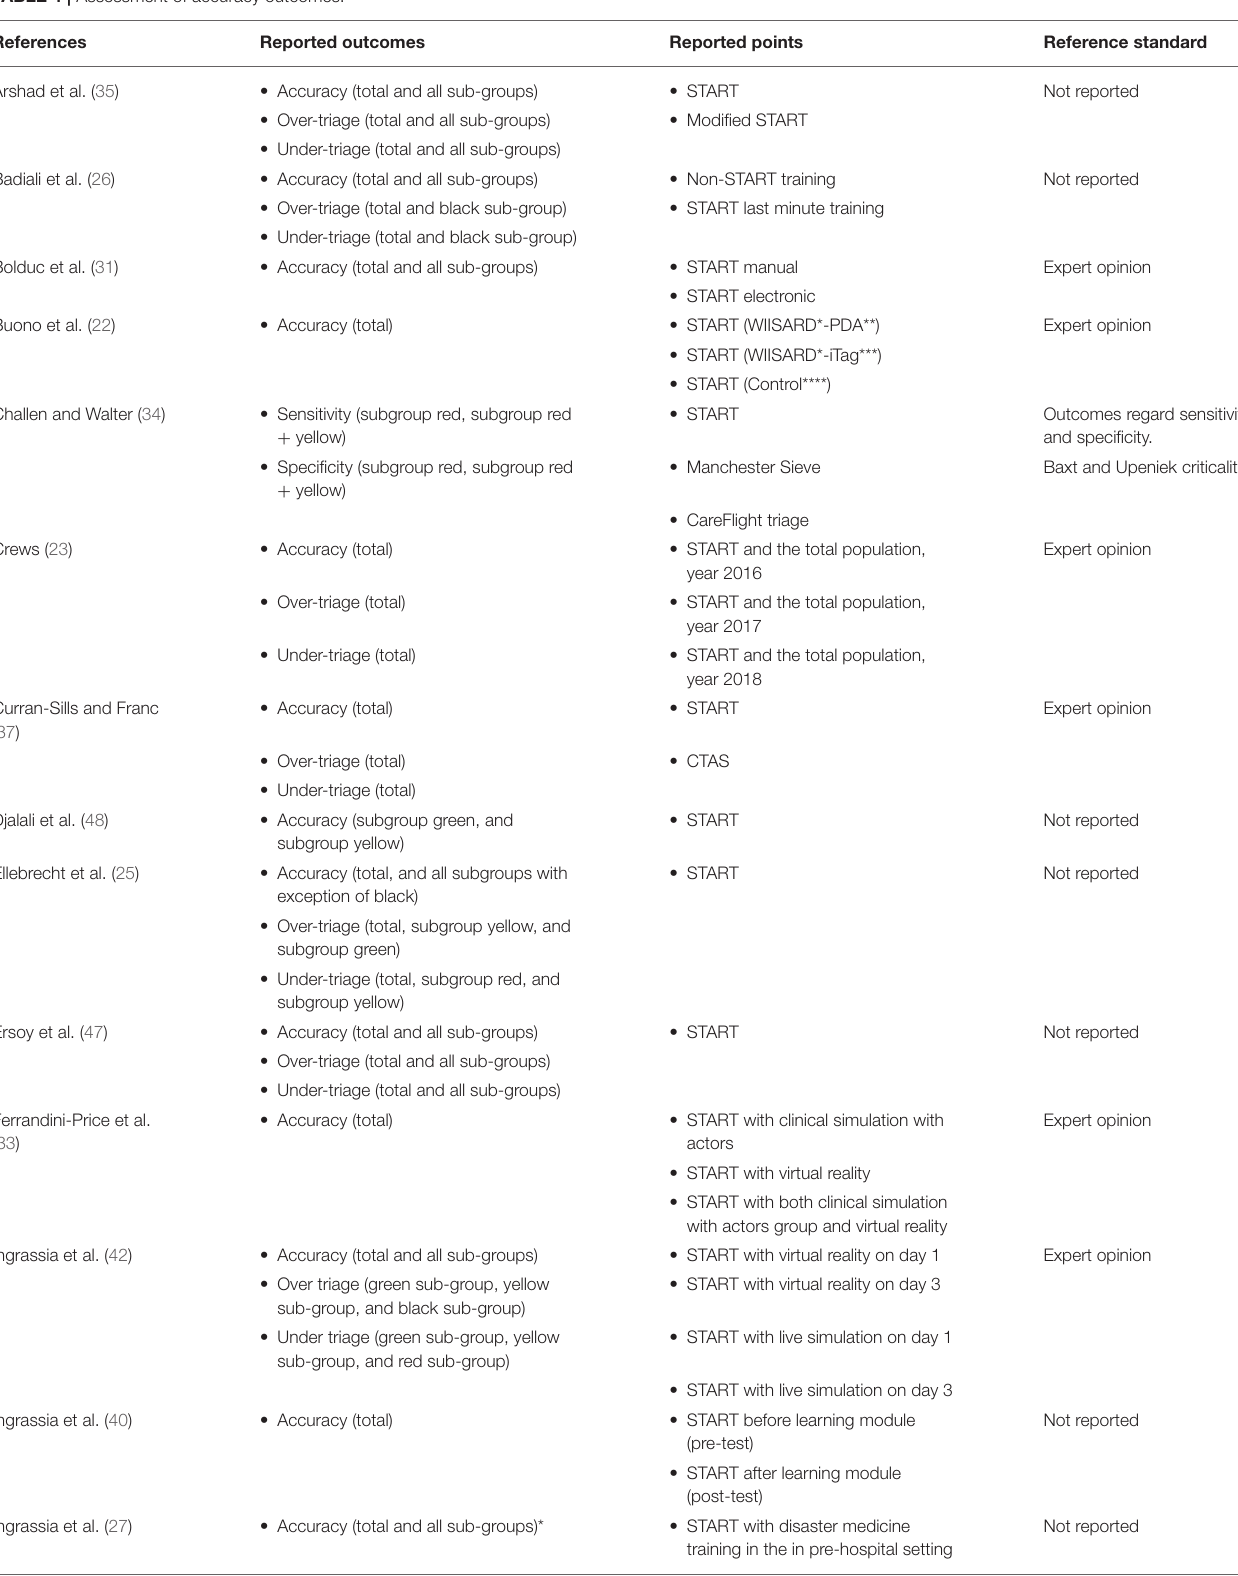
TABLE 4 | Assessment of accuracy